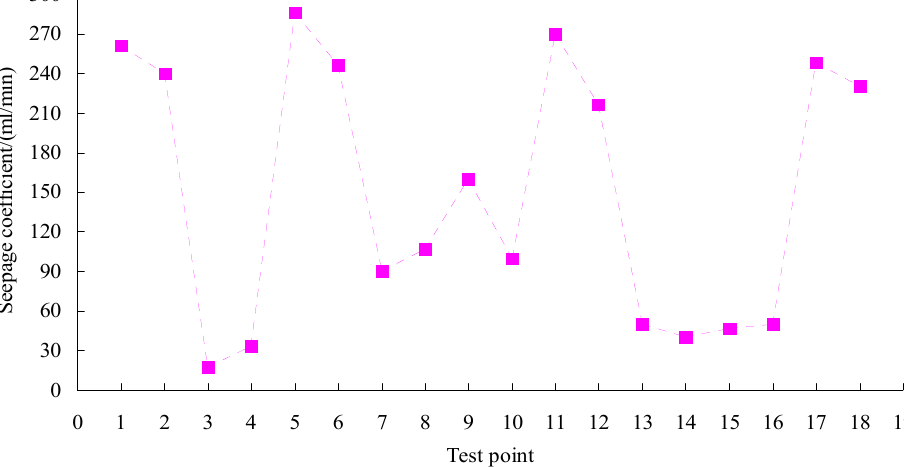
Figure 11. Test results of permeability coefficient for test road.